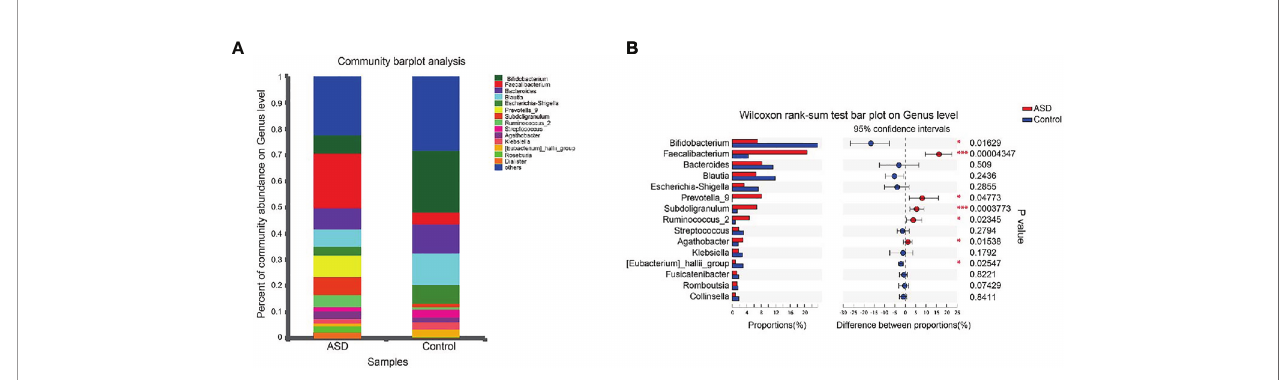
FIGURE 4 | Microbial structures and the differences of genus between two groups (red: ASD group; blue: control group). (A) The community abundance of gut microbiota on genus level; (B) The difference of gut microbiota between ASD and control group on genus level. *P < 0.05 and ***P <